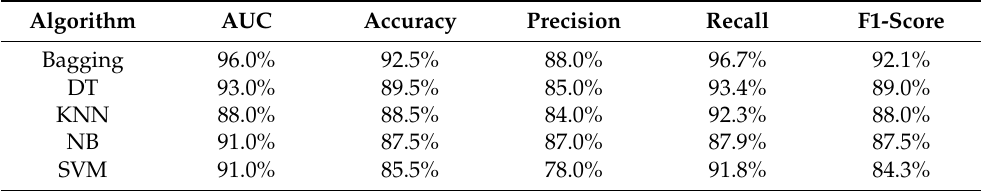
Table 6. Improved model performance comparison of algorithms.